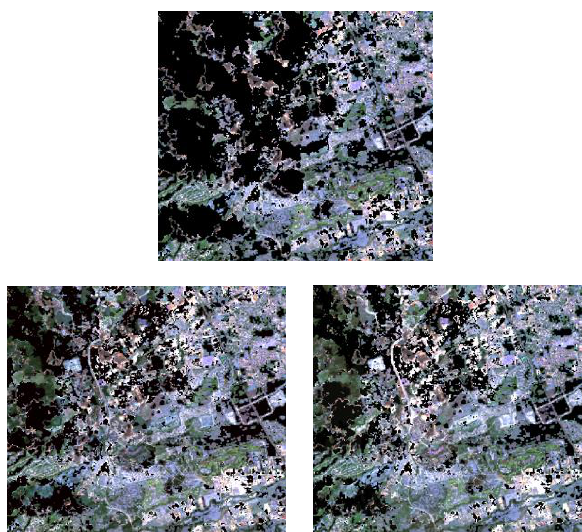
Figure 2 Raw reference image (top); reference image filled with unadjusted image at cloud mask (bottom left); reference image filled with adjusted image at cloud mask (bottom